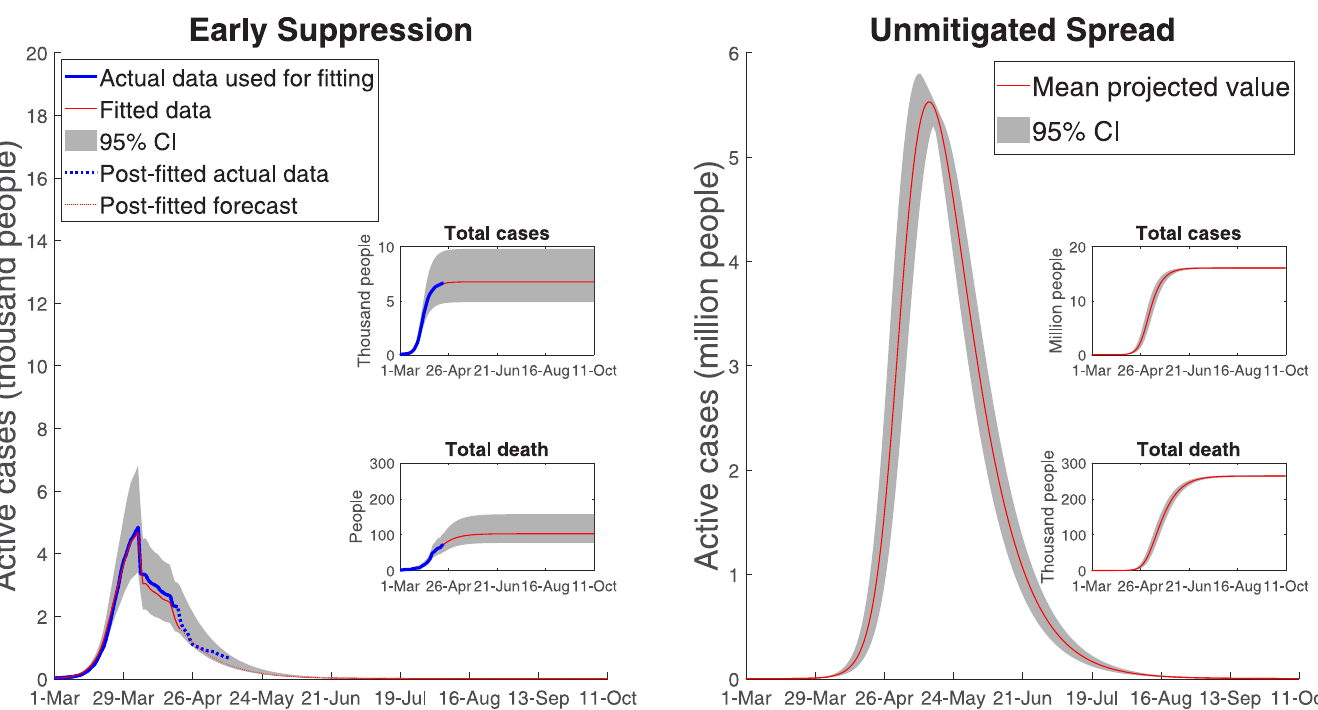
Fig 5. Australian COVID-19 dynamics: Early and unmitigated spread.